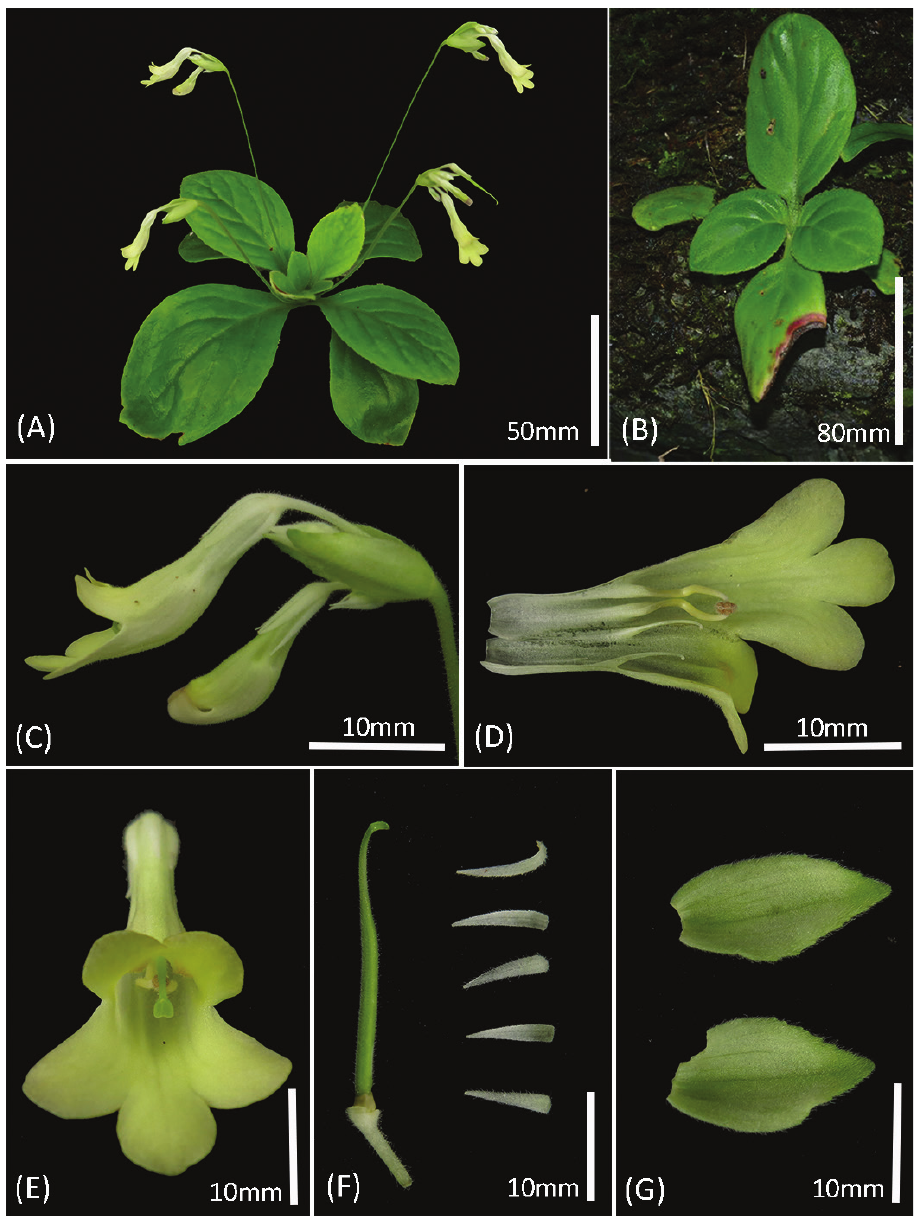
Figure 2. Primulina malipoensis . A flowering plant cultivated in South China Botanical Garden B plant in natural habitat C flower in side view D opened corolla, showing stamens and staminodes E flower in front view F pistil and calyx G bracts. Photographs by Li-Hua